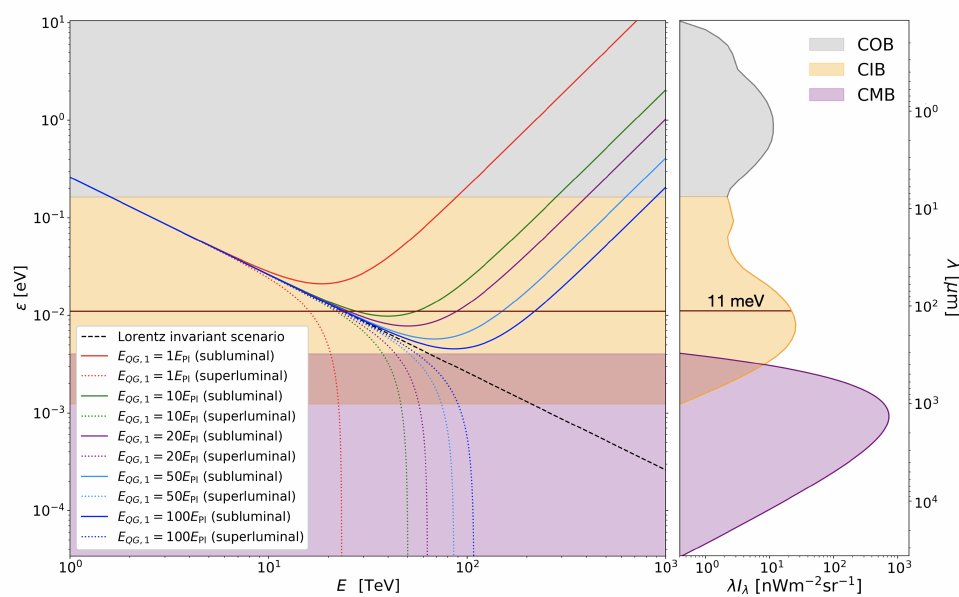
Figure 1. ( Left ) Energy of the background photons at threshold ( (cid:101) th ) for the pair-production reaction as a function of a gamma-ray energy ( E ) . The black dashed line represents the Lorentz invariant scenario, while solid and doted lines represent LIV subluminal and superluminal scenarios, respectively. Five different values of E EG,1 were considered. ( Right ) Spectral energy distributions of the CMB and the two constituents of the EBL (cosmic optical background and cosmic infrared background) were produced using the EBL model by Domínguez et al.